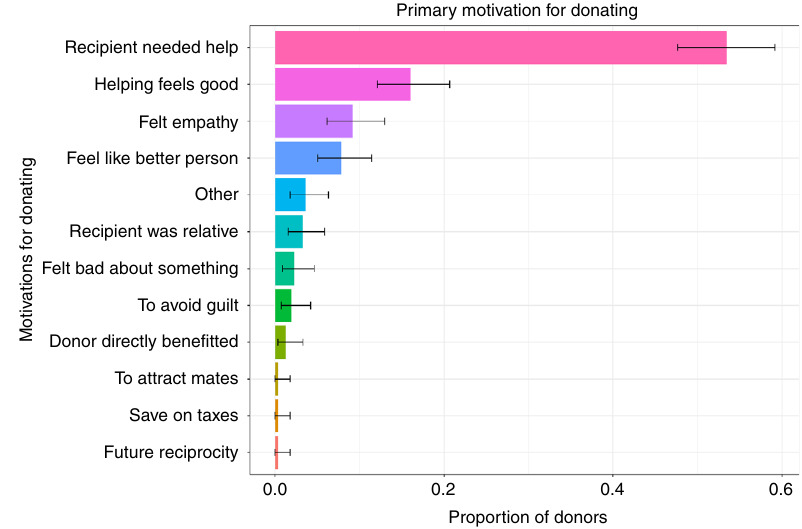
Fig. 1 Primary motivation for donating. This fi gure depicts what proportion of donors reported each potential motivation for donating as their primary motivation. Donating primarily because the recipient needed help was reported by 53.4% of survey respondents. Source data are provided as a Source Data fi le. Error bars depict 95% con fi dence intervals